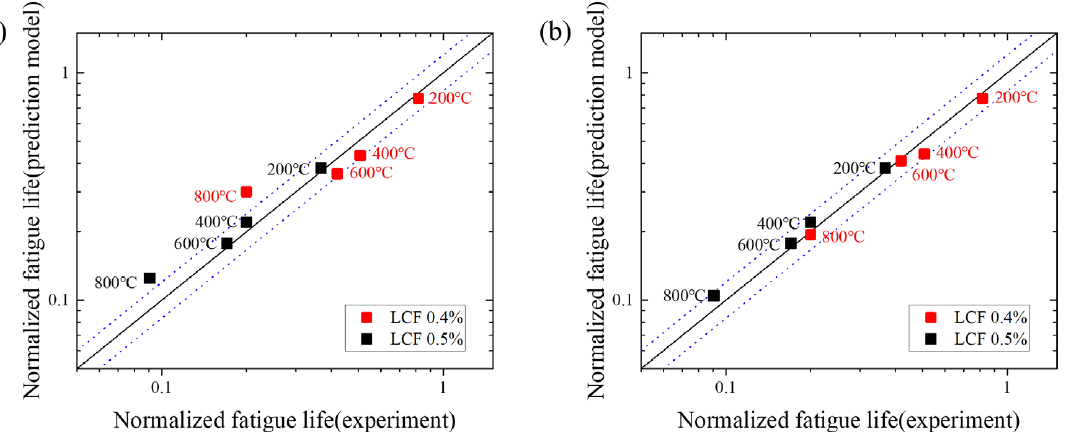
Figure 8. Experimental fatigue cycles to failure and lifetime model estimation for the LCF; ( a ) mechanism-based lifetime model only; ( b ) prediction model considering the oxidation damage.